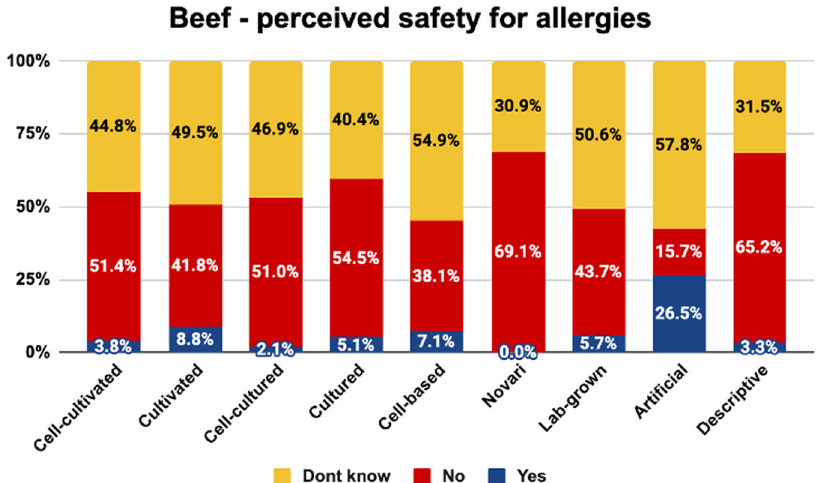
Fig. 7 Perceived allergen safety of beef by label. The graph shows the proportion of people who correctly identi fi ed that cell-cultivated beef products are not safe for allergy-sufferers, incorrectly identi fi ed that they are safe for allergy sufferers, and did not know.